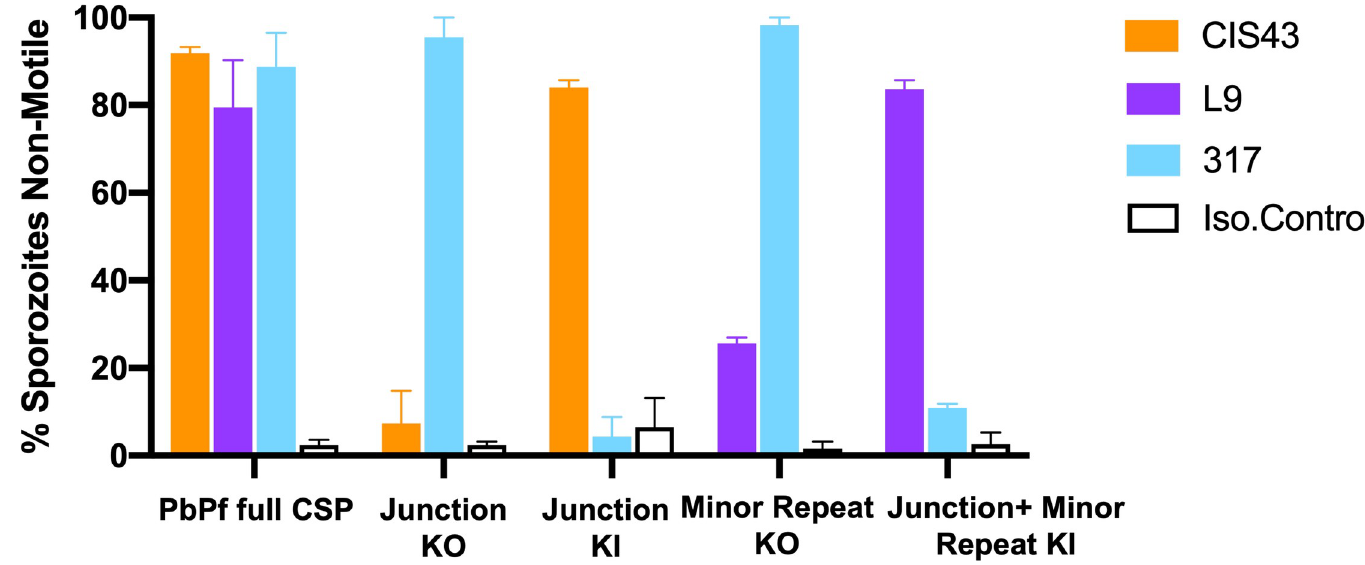
Fig 3. Quantitative analysis of PfCSP mAbs immobilizing SPZ in vitro . Effect of mAbs on in vitro motility of freshly isolated transgenic KO/KI SPZ lines. The percentage of SPZ that became non-motile after incubation with CIS43 (50 μ g/ml) or L9, 317 or isotype control (25 μ g/ml each) for 15 minutes at 37˚C was determined using time-lapse microscopy. The bar graphs show the mean and standard error of the percentage of non-motile SPZ from two independent experiments.